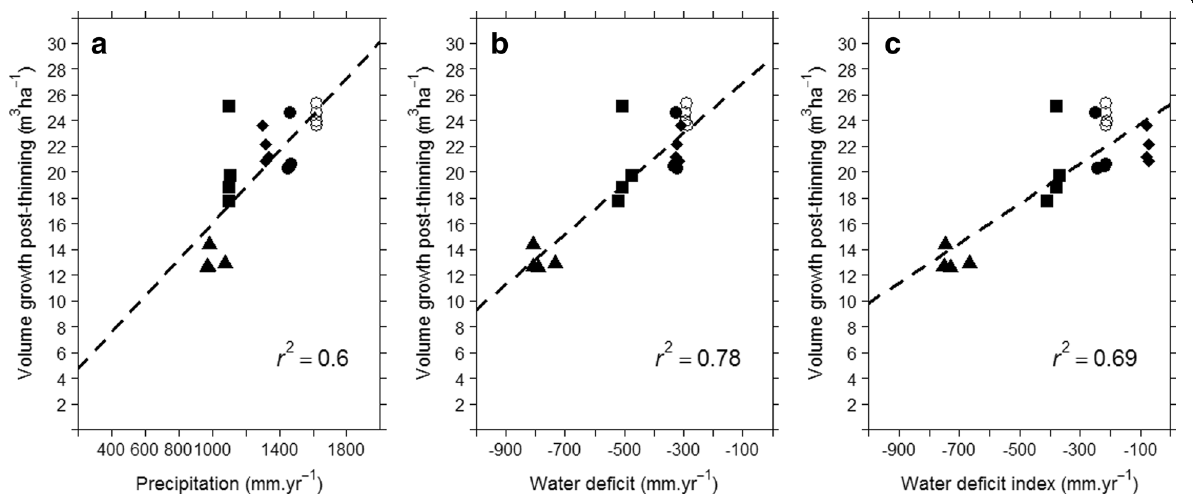
Fig. 3 Relationship between incremental volume growth 1 year post thinning and precipitation ( a ), water deficit ( b ), and water deficit index ( c ) for sites P800 (filled triangles), P1100 (filled squares), P1500 (open circles), P1700 (filled circles), and P1750 (filled